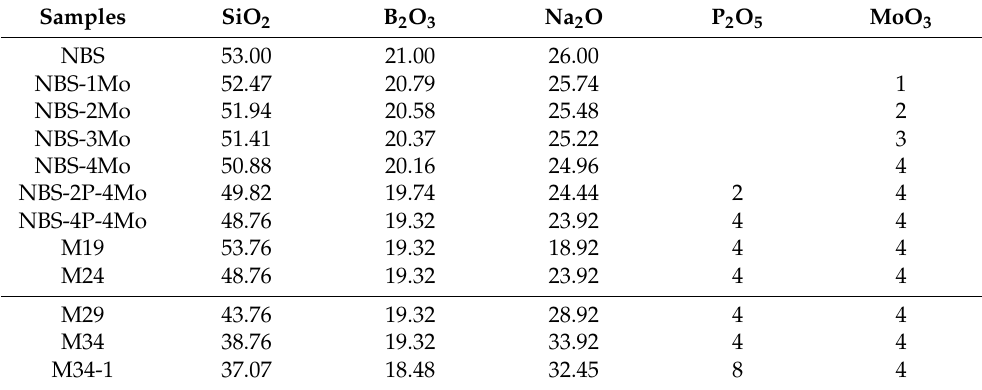
Table 1. Composition of glasses in the present study